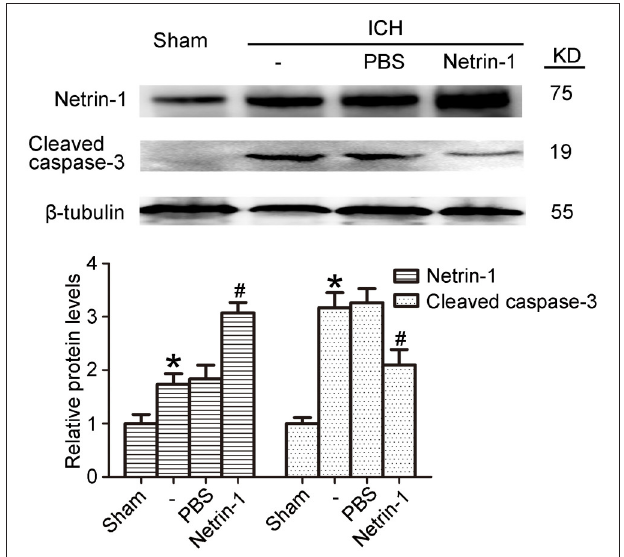
FIGURE 8 | Effects of exogenous recombinant netrin-1 on interactions between netrin-1 and DCC/UNC5H2 . Netrin-1/DCC and netrin-1/UNC5H2 interactions in the peri-hematoma cortex were assessed by a co-immunoprecipitation assay. All values are expressed as mean ± SEM. Mean values of protein levels in the sham group were normalized to 1.0. * p < 0.05, ** p < 0.01 vs. the sham group. # p < 0.05, ## p < 0.01 vs. the ICH + PBS group, n = 6.